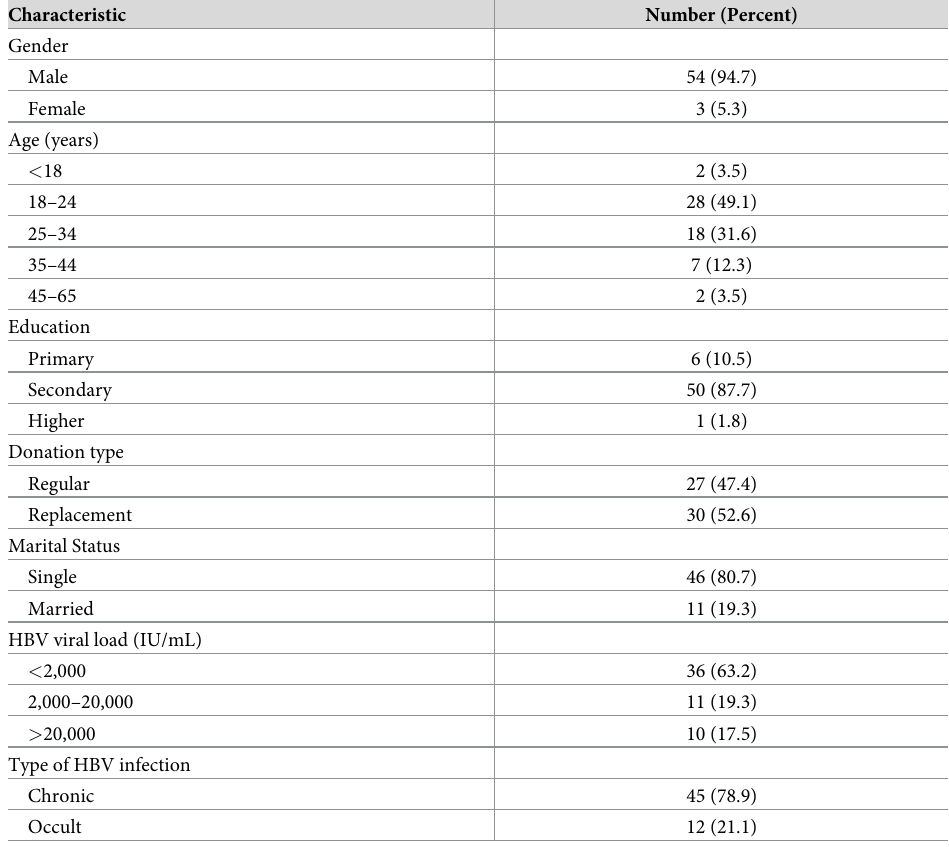
Table 1. Sociodemographic characteristics of the 57 study participants.